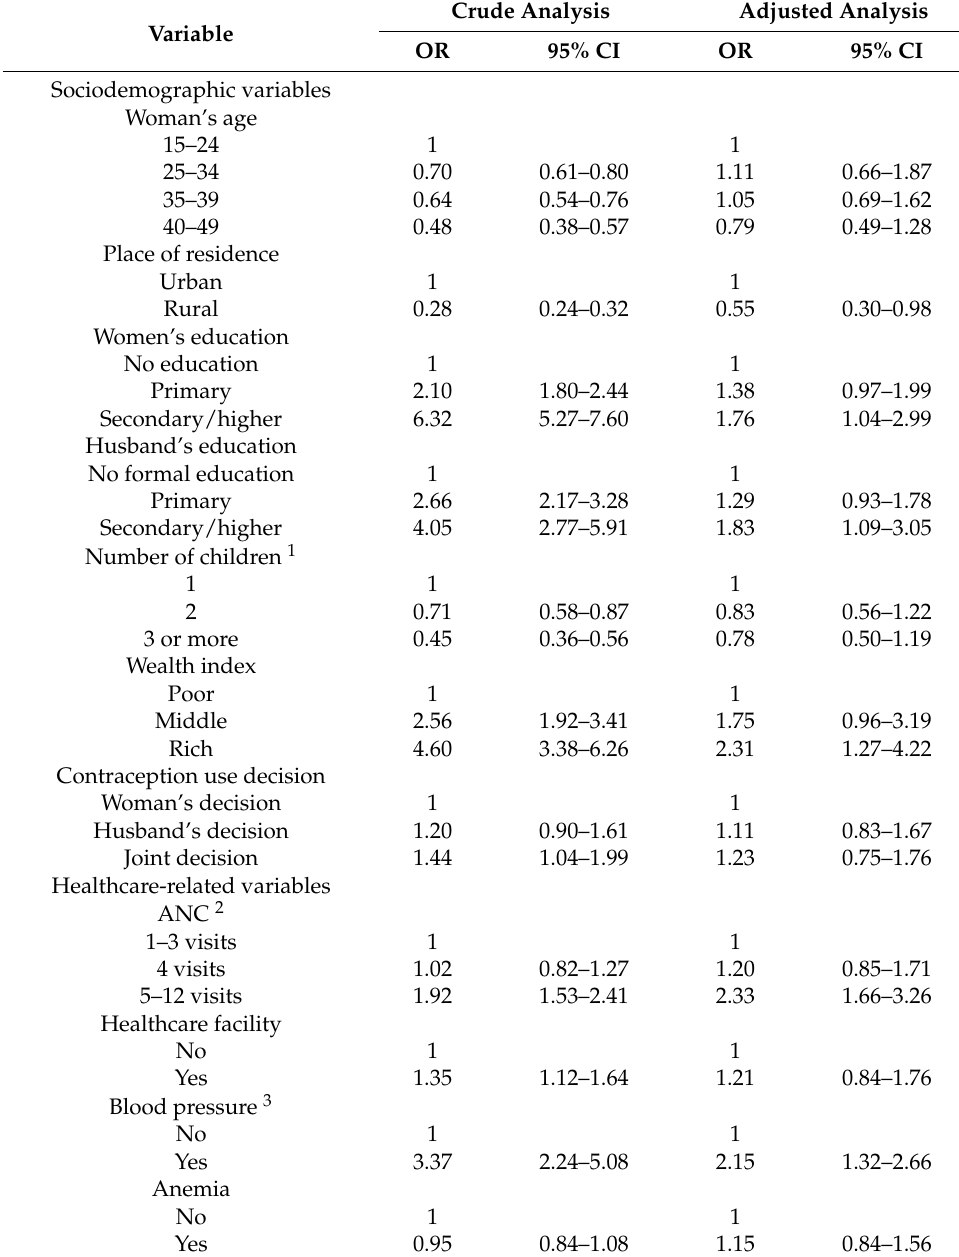
Table 3. Logistic regression showing the crude and adjusted odds ratio (OR) with 95% confidence intervals (CIs) for utilization of institutional delivery services among women in